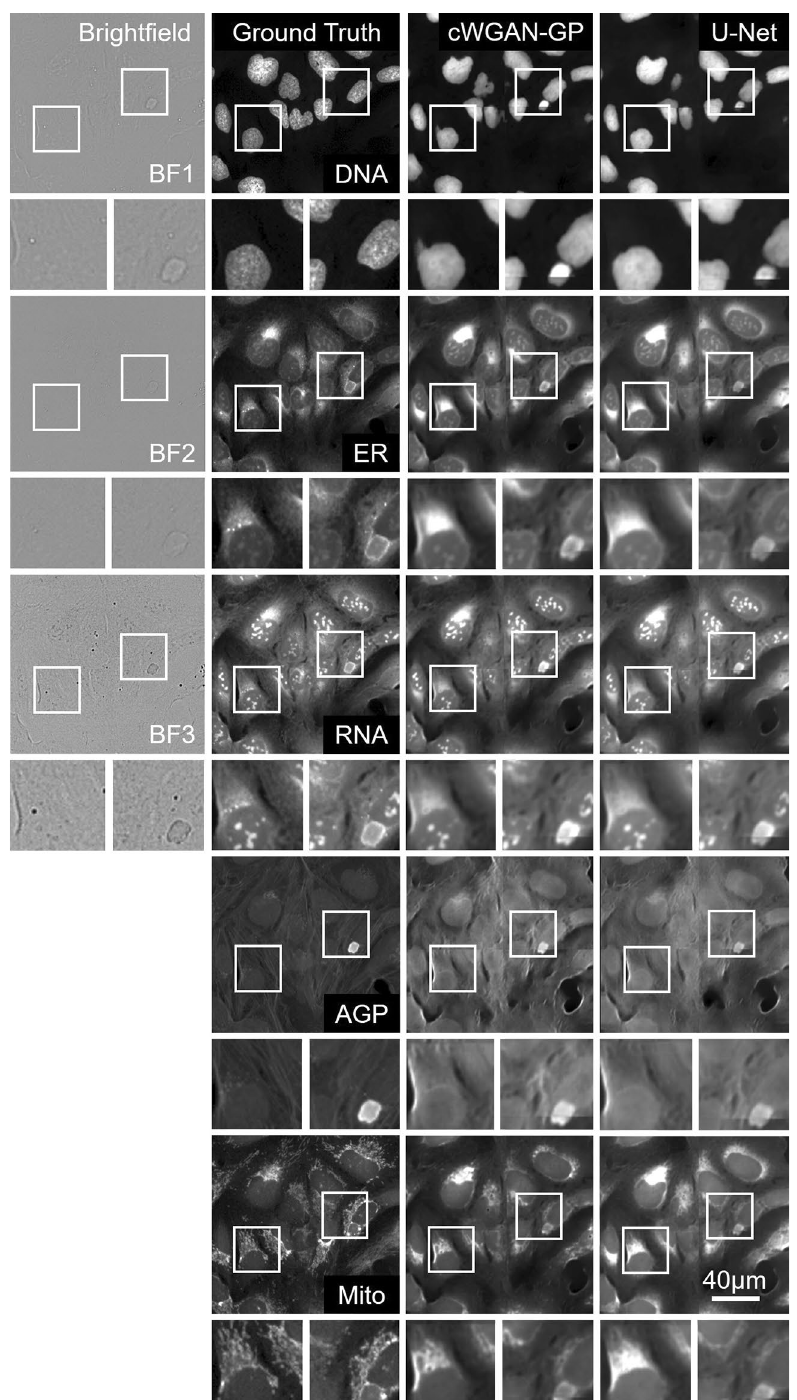
Figure 3. Two small outsets for each image show a magnified view of the selected region of the cell and can be used to compare details between the ground truth and the two model outputs in each channel. Images are independently contrasted for